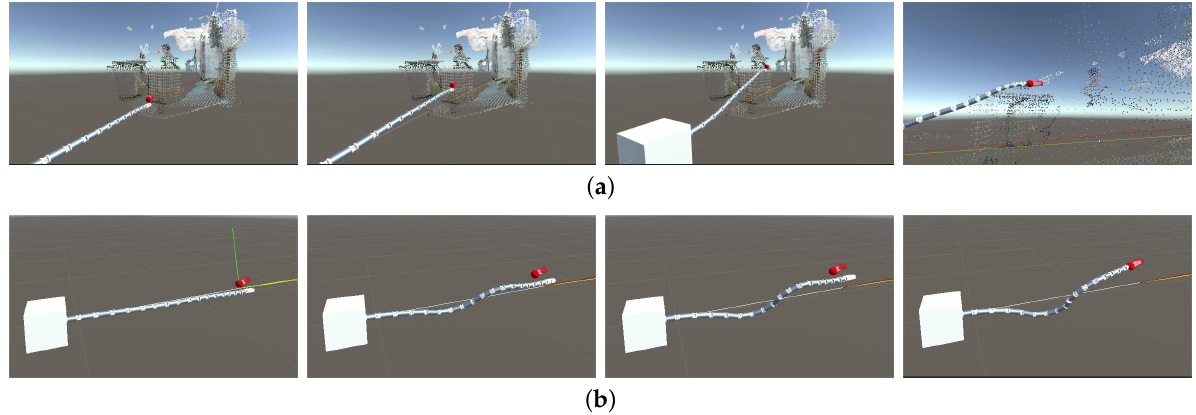
Figure 8. Results in chronological order of the ( a ) configuration planning simulation and ( b ) configu- ration planning simulation with the Base Lock option